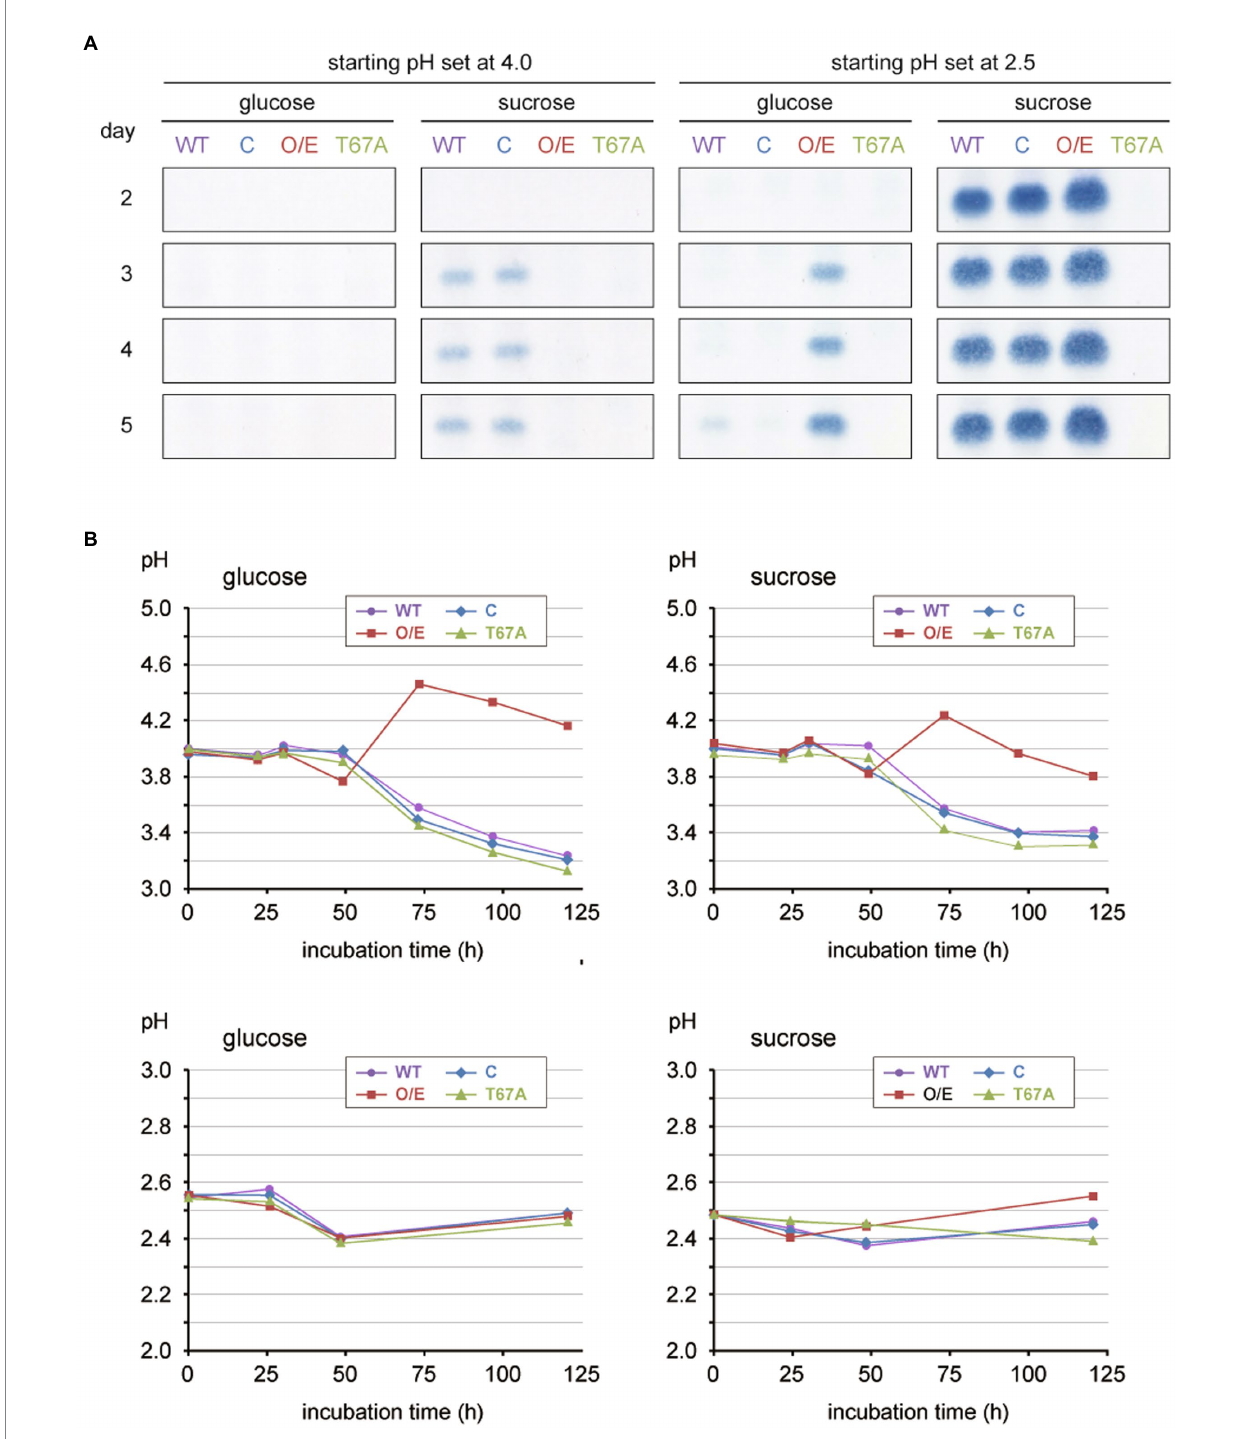
FIGURE 1 Toxin production assay of the various Fgp1 mutant strains with two independent parameters, carbon source (glucose and sucrose) and initial pHs (4 and 2.5), cultured on 30 mL of medium in a 100-mL Erlenmeyer flask with gyratory shaking (135 rpm) at 25 ° C. (A) Each of the four strains tested (wild- type, WT; complemented, C; overexpressor, O/E; phosphorylation site mutant, T67A) was cultured on the defined media with amino acids mixture nitrogen source (Supplementary Table 1), and the carbon source and initial pH as indicated at the top. Each culture was sampled on days 2, 3, 4 and 5 of incubation. TLC panels show the spots of 15-ADON extracted from 500 μ L of the medium with ethyl acetate. (B) Time course of pH changes of each fungal culture. When cultured at initial pH of 4, the wild-type, complemented, and T67A strains exhibited similar pH profiles, while the overexpressor displayed an increase in pH and deviated from the other three strains (upper graphs). When cultured at initial pH of 2.5, all four strains exhibited similar pH profiles (lower